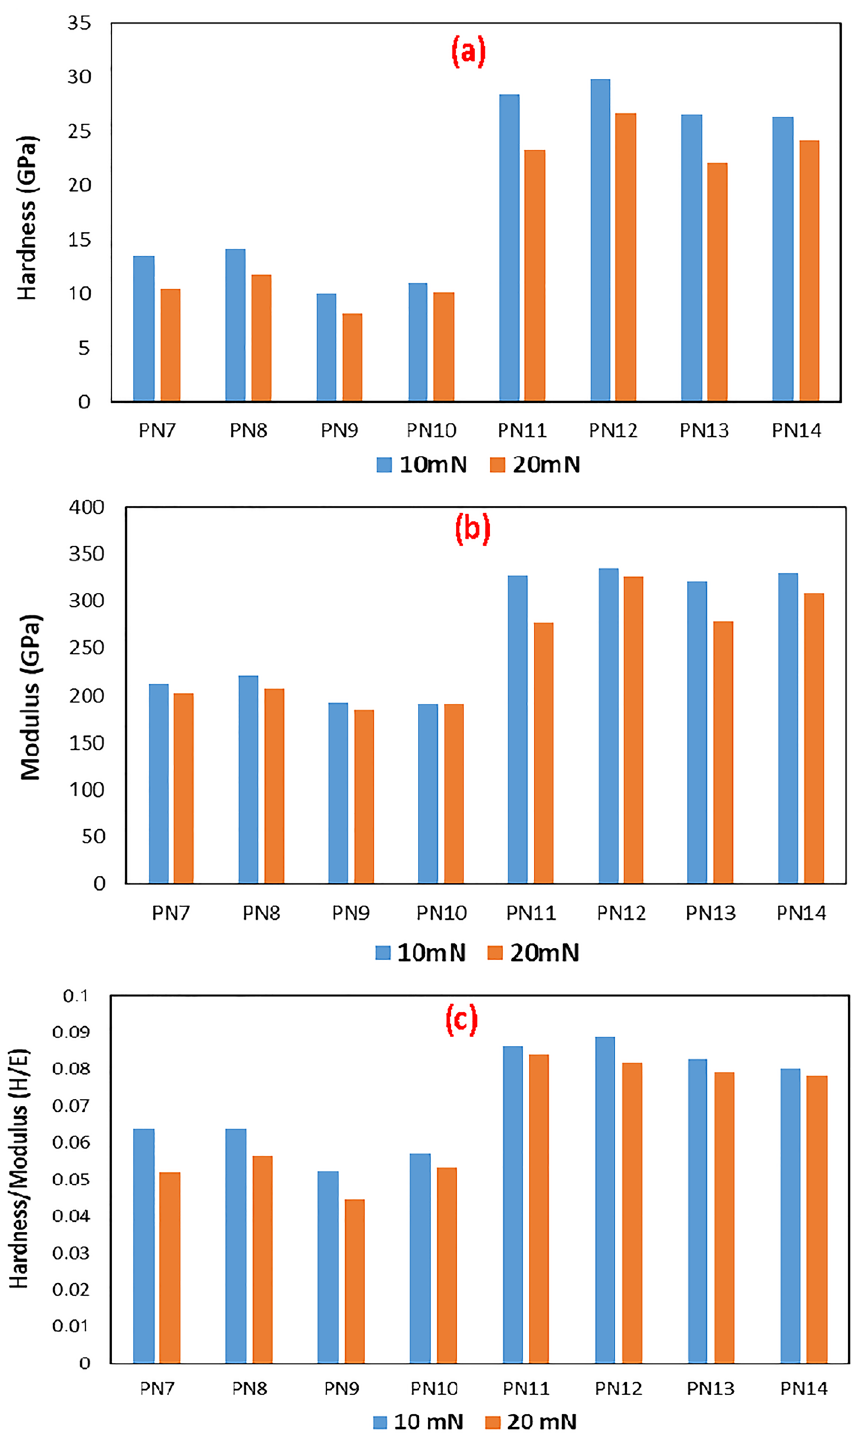
Figure 11. Bar charts showing values of (a) hardness, (b) elastic modulus and (c) hardness/elastic modulus (H/E) values for all the studied multilayer